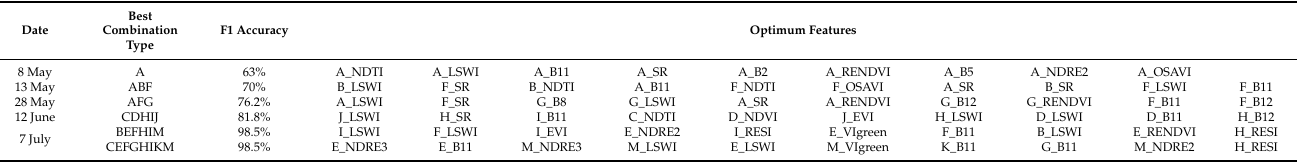
Table 12. The top-10 optimal feature set of best soybeans combination types for each period in 2020.